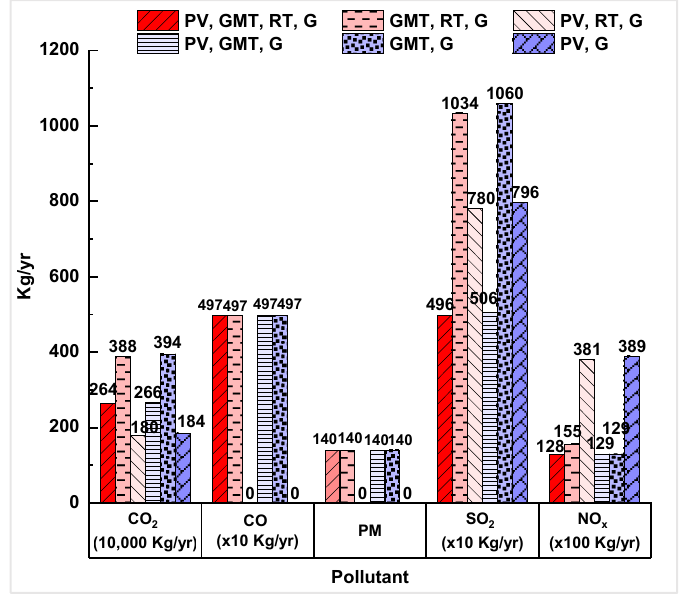
Figure 9. Comparison of level of pollutants from the six systems.